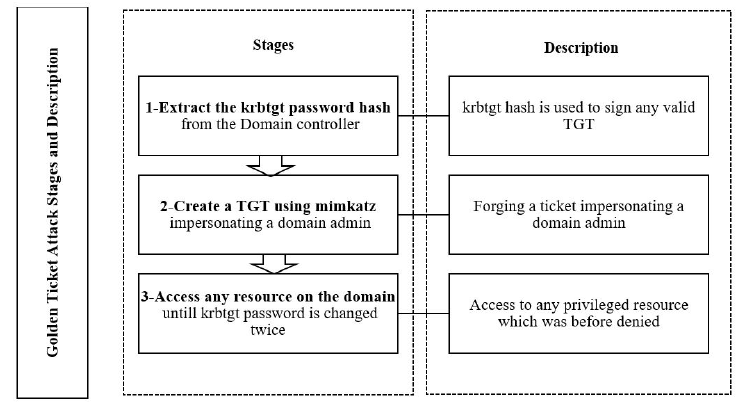
Figure 6. Golden Ticket Attack Stages.